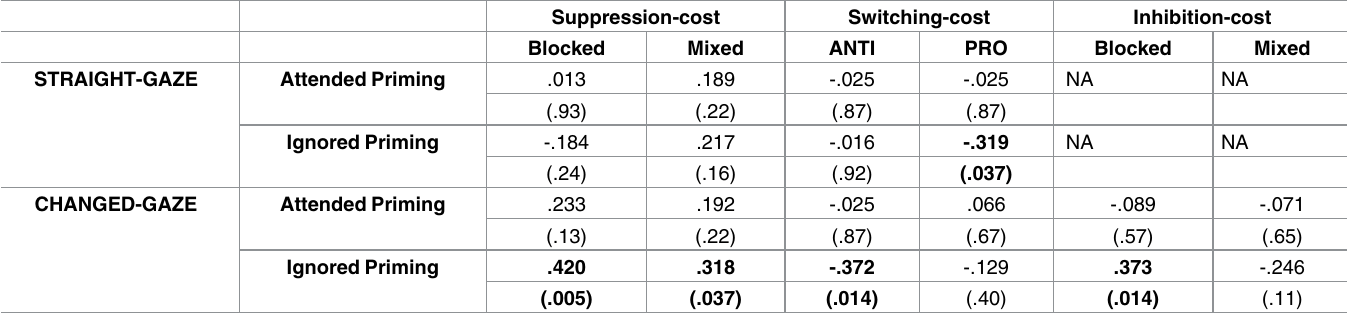
Table 3. Correlation